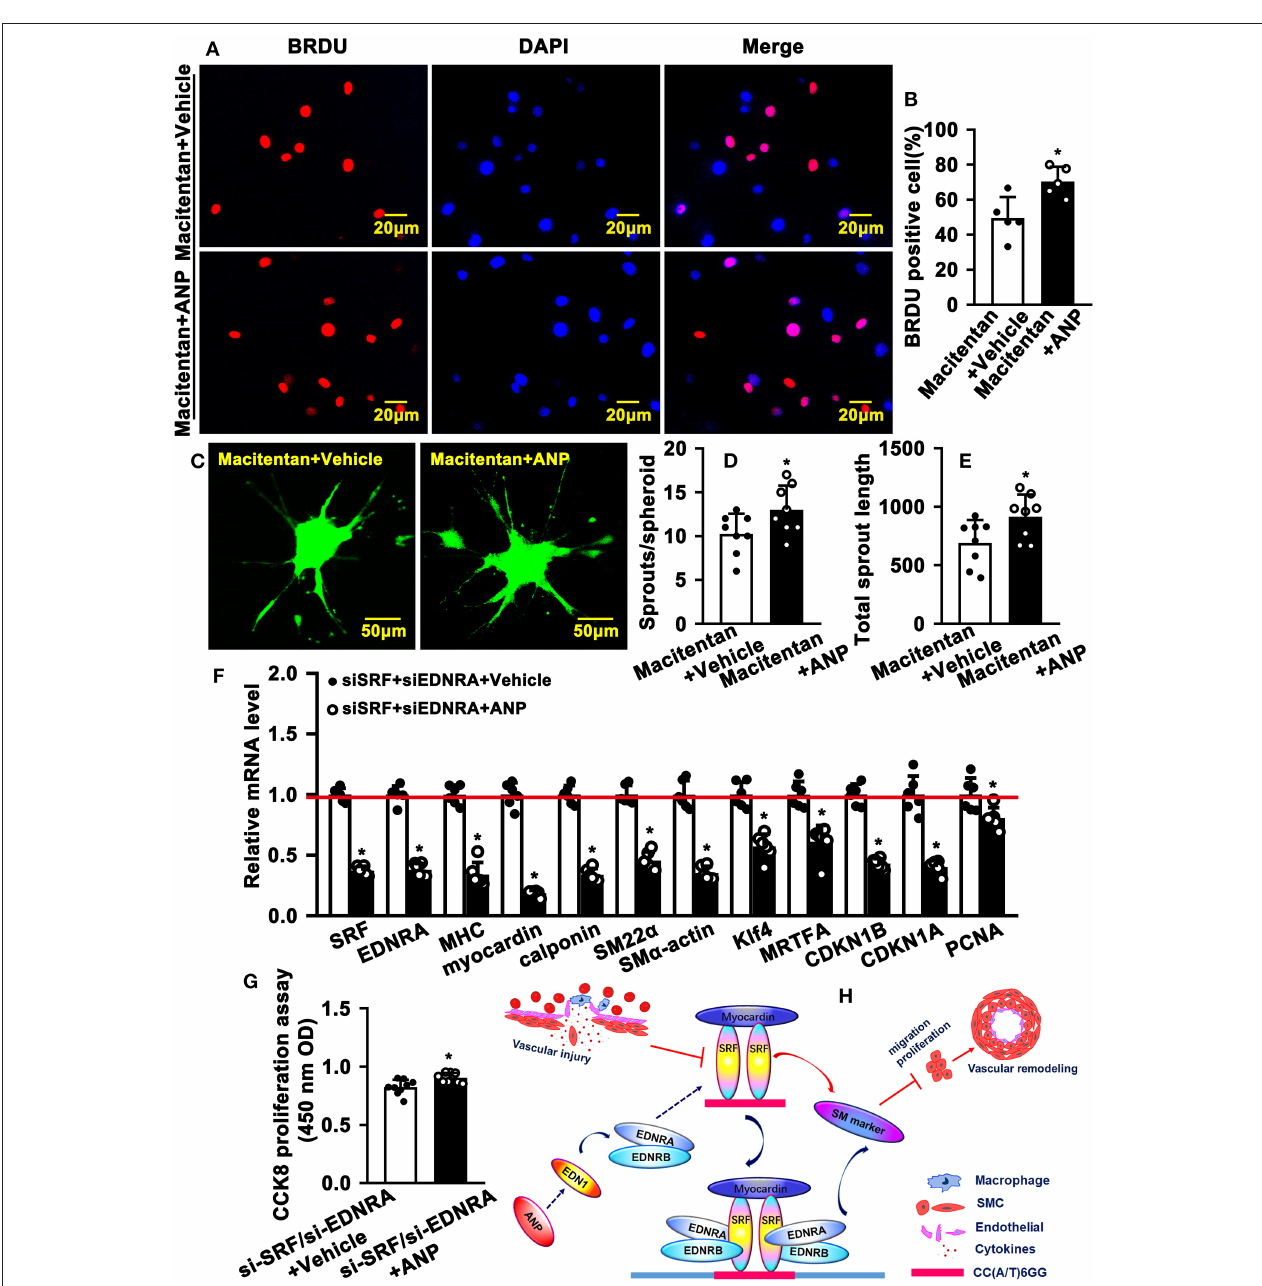
FIGURE 7 | Inhibition of endothelin receptors and SRF attenuates Andrographolide-promoted SMC dedifferentiation. (A) Rat SMCs were treated with Macitentan (1 µ M) and Andrographolide (5 µ M), followed by incubation with BRDU labeling buffer for 20h. Immunofluorescence staining was performed to observe BRDU incorporation, and BRDU-positive cells were quantified, as shown in (B) ( n = 5). (C) A spheroid sprouting assay was performed in the presence of Macitentan (1 µ M) and Andrographolide (5 µ M). The sprouting was visualized by calcein AM staining, and sprouts and sprouting length are quantified in (D,E) ( n = 8). (F) Rat SMCs were transfected with small interfering RNA si-SRF and si-EDNRA for 4-6h, and then treated with Andrographolide (5 µ M) for 30h, the mRNA levels of SMC-specific marker genes, including SRF, Myocardin, MHC, calponin, SM22 α , SM α -actin, KLF4, and MRTFA, and proliferation-related genes including CDKN1A, CDKN1B, and PCNA were detected by real-time PCR ( n = 6). (G) Rat SMCs were transfected with small interfering RNA si-SRF and si-EDNRA for 4–6h, and then treated with Andrographolide (5 µ M) for 24h, the cell viability was detected by CCK8 ( n = 9). Data are presented as mean ± SEM. * P < 0.05. (H) The schematic diagram indicates that vascular injury suppresses the expression of SRF and Myocardin, resulting in decreased expression of SMC-specific marker genes, which is characterized by enhanced proliferation and migration, eventually leading to vascular hyperplasia. Treatment of SMCs with Andrographolide activates the endothelin signaling pathway and promotes the interaction of EDNA and EDNB with the Myocardin-SRF complex to induce SMC-specific marker gene expression.